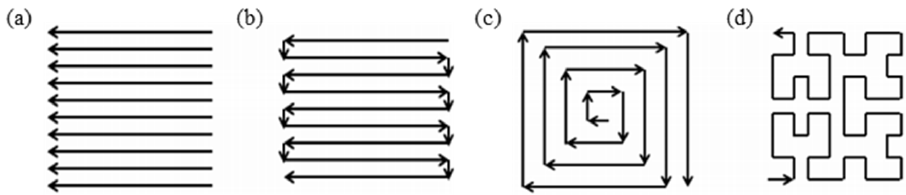
Figure 6. Different deposition patterns: ( a ) raster; ( b ) bi-directional; ( c ) offset-out; ( d ) fractal [14]. Therefore, in the melt pool of LMD, the crystal grain morphology is dominated by equiaxed grains on the surface of the melt pool and columnar grains at the bottom. The columnar grains grow at the bottom of the melt pool along the direction perpendicular to the solid–liquid interface and closest to the heat flow. When the multi-layer laser cladding is processed, the equiaxed grains on the upper part of the melt pool in the previous cladded layer may be remelted, so that the columnar grains at the bottom of the melt pool can grow. It is worth noting that during the LMD process, the laser scanning strategy can affect